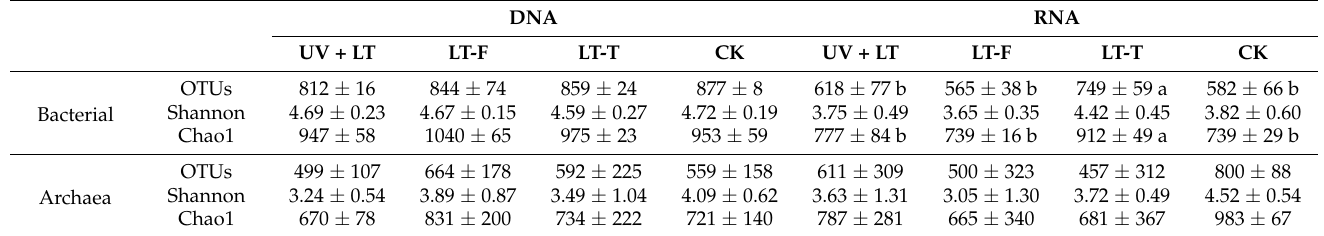
Table 1. The alpha diversity indexes of bacteria and archaea based on the OTUs data. DNA RNA